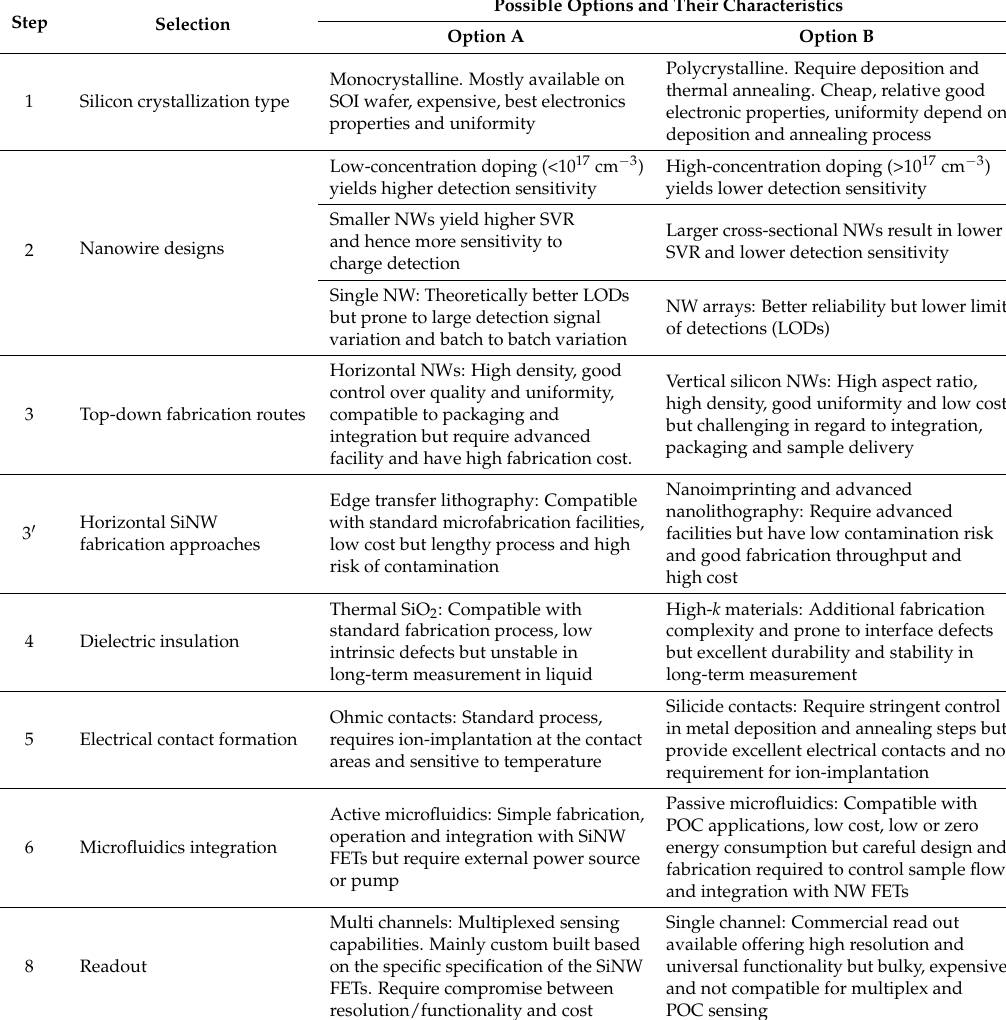
Fabrication process selection frame work of SiNW FET biosensor according to application